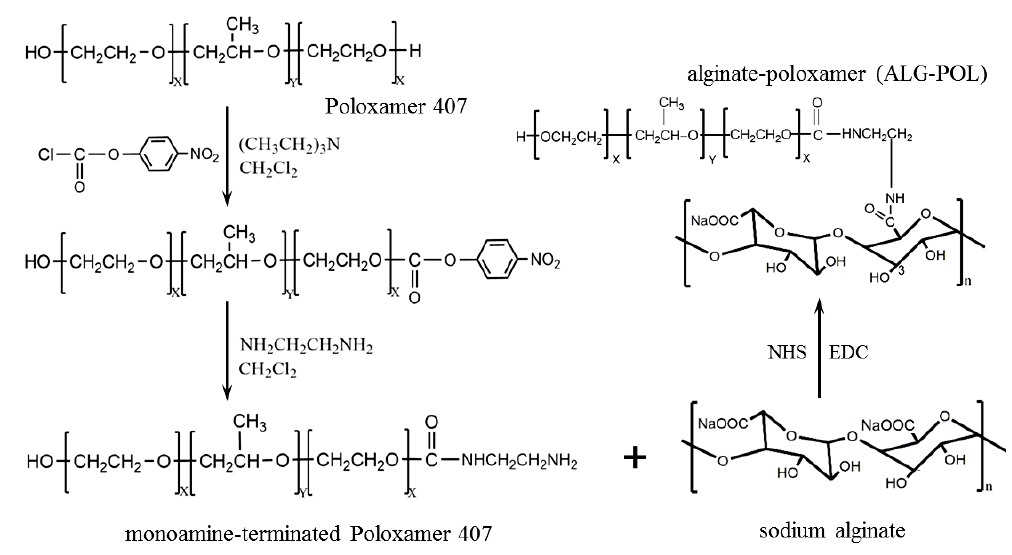
Figure 1. Schematic illustration for synthesis of alginate–poloxamer copolymer.